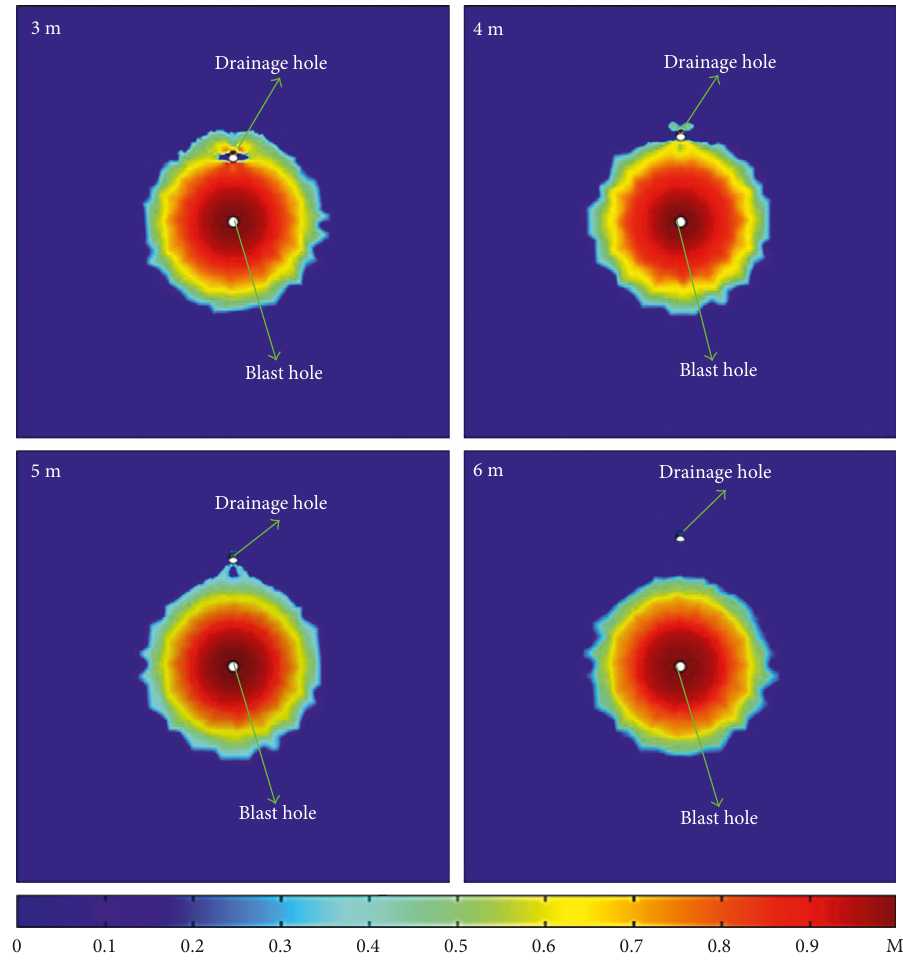
Figure 12: Degrees of coal damage and damage ranges for different borehole